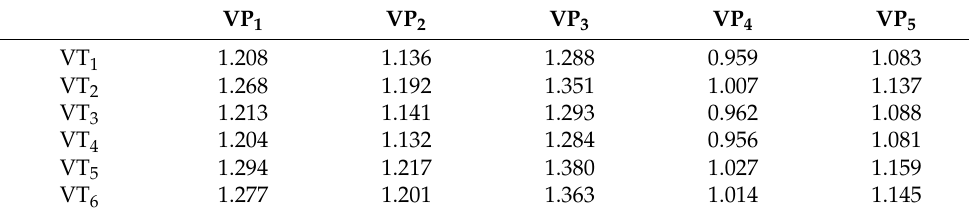
Table 7. Average values of correspondence between VT i and VP j in the first approach of the analysis.